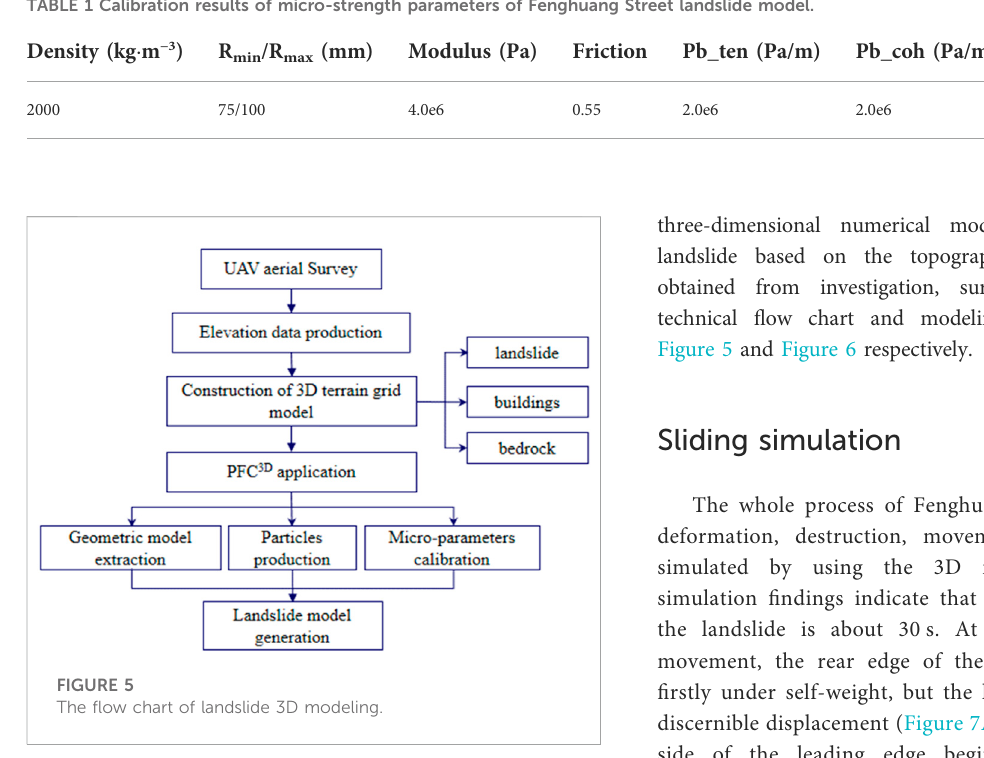
TABLE 1 Calibration results of micro-strength parameters of Fenghuang Street landslide model.